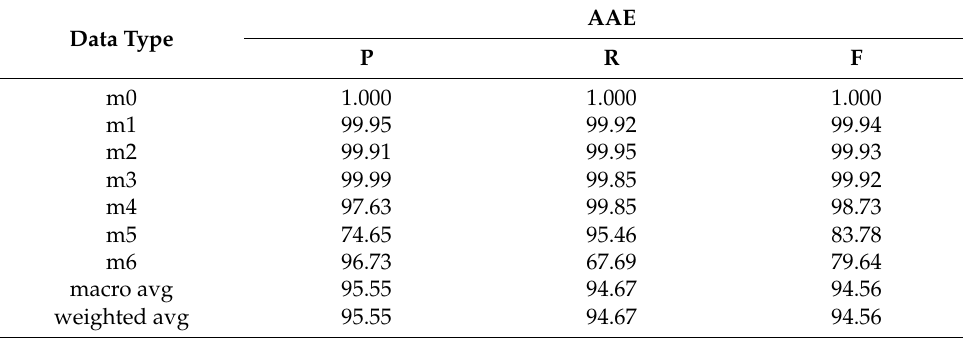
Table 4. Accuracy of M0–M6 data generated by AAE.